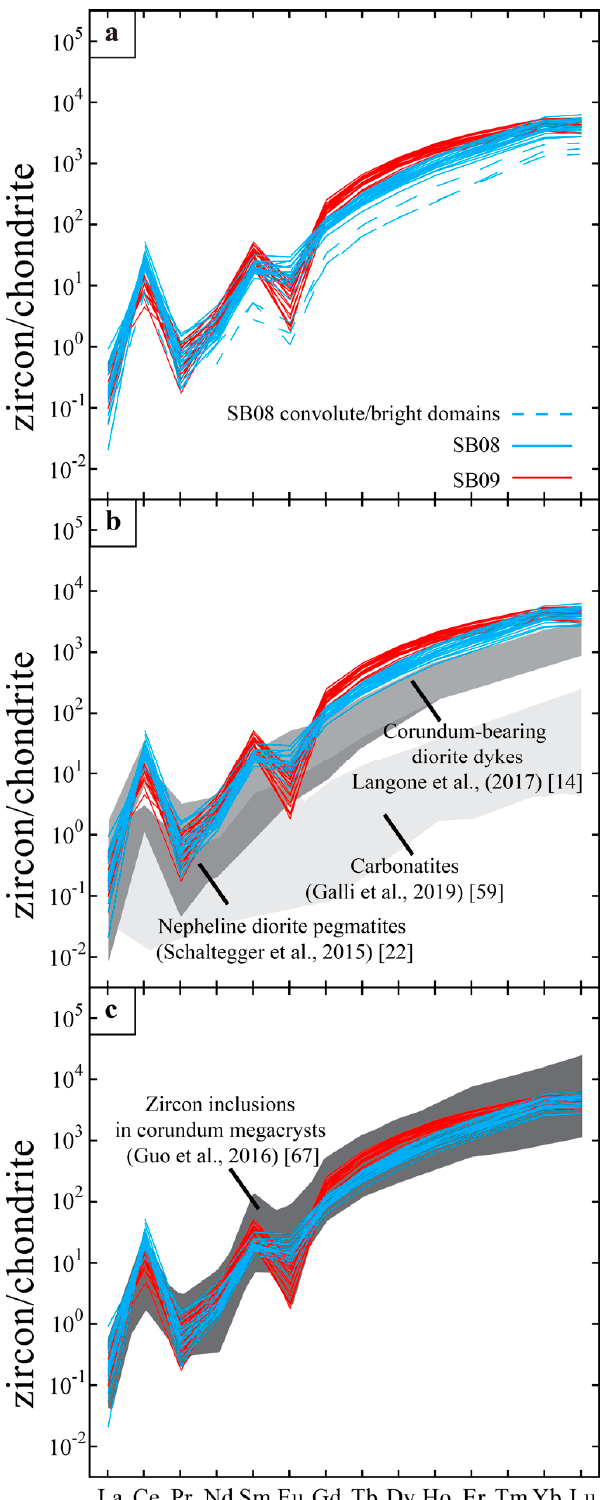
Figure 9. Carbonaceous Ivuna (CI) chondrite normalized rare earth elements (REE) patterns of zircon from SB09 and SB08 dykes ( a ), comparison with REE pattern of zircons of felsic dykes and carbonatites of the IVZ ( b ) and zircon included within corundum megacrysts in alkali basalts ( c ). CI normalization values are from McDonough and Sun [69].